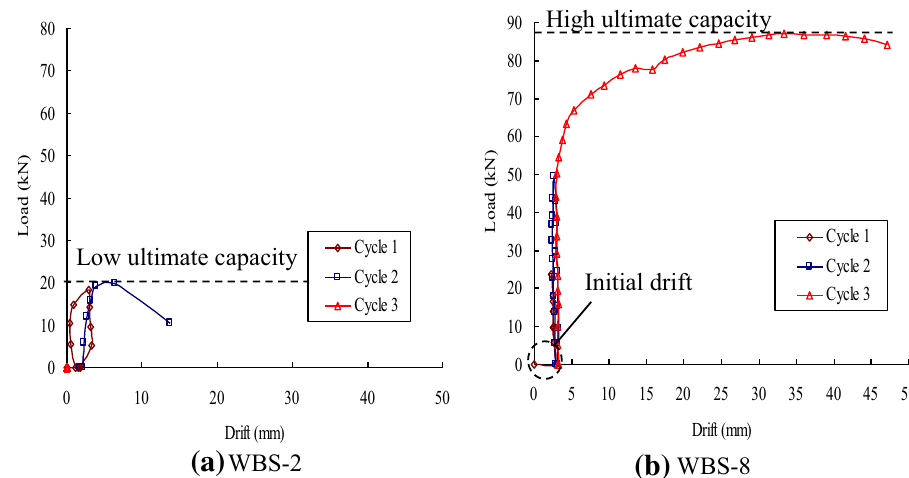
Fig. 12 Load-drift response of wall assembly specimen under flexural load.